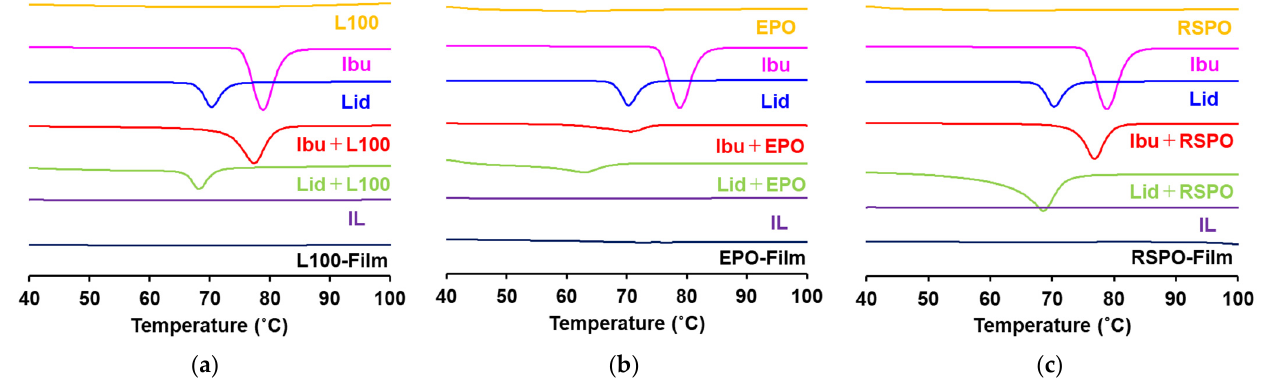
Figure 5. DSC analysis of the components of printer ink, the combination of drug and Eudragit polymers, ILs, and IL-loaded films. ( a ) DSC analysis of L100-containing samples. ( b ) DSC analysis of EPO-containing samples. ( c ) DSC analysis of RSPO-containing samples.